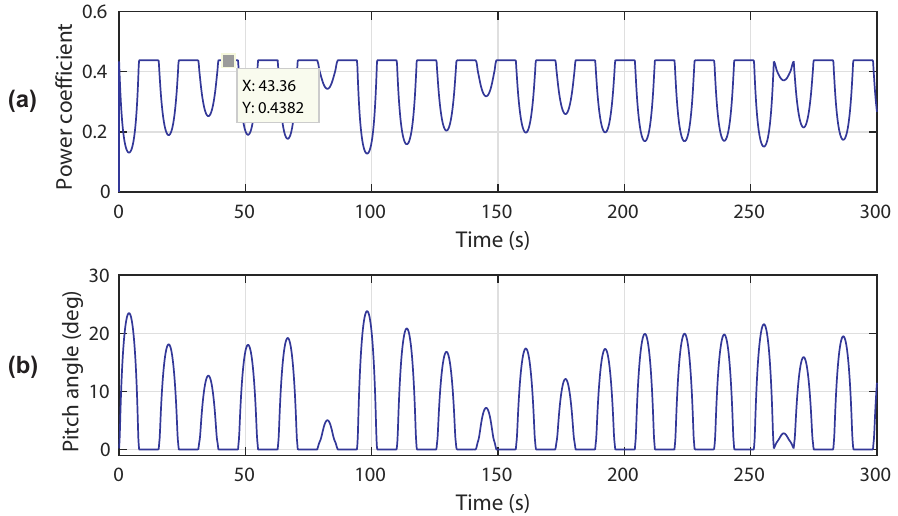
Figure 18. Control performances in scenario 2: ( a ) power coefficient response; ( b ) pitch angle